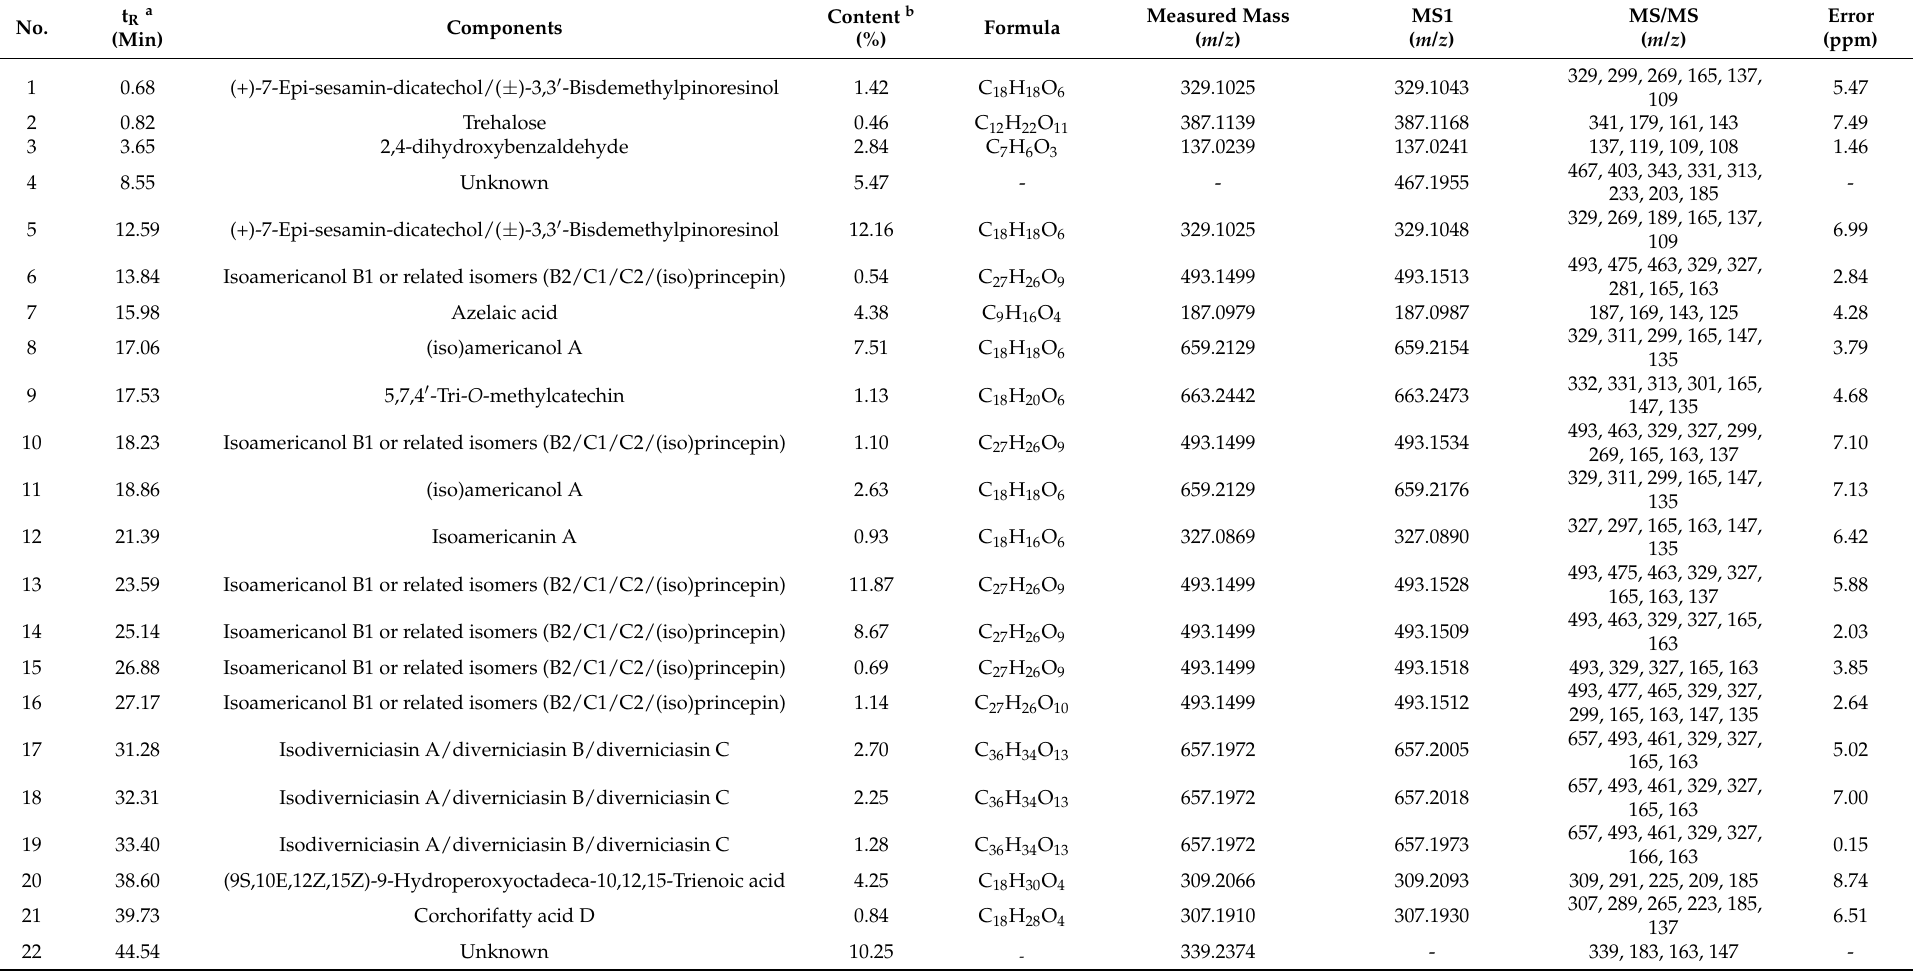
Table 2. Compounds tentatively identified from EA extracts of tung meal by